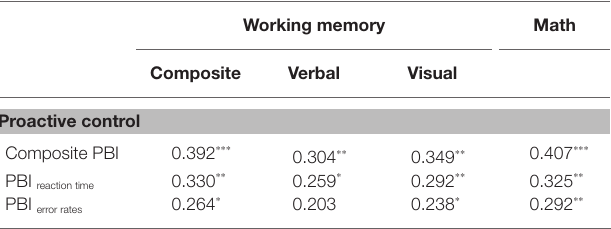
TABLE 3 | The correlations of proactive control with both working memory and math